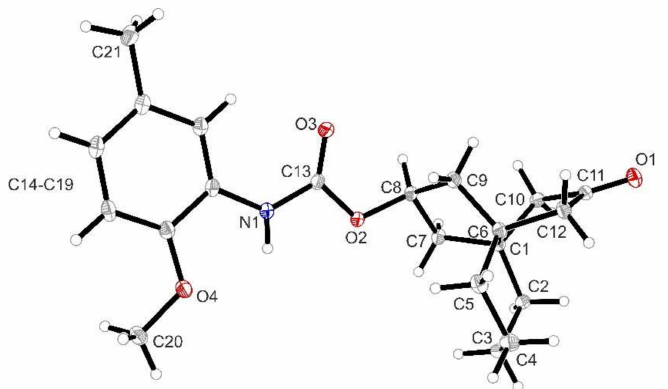
Figure 4. X-ray crystal structure of carbamate syn -7. Thermal ellipsoids are set at 15% prob- ability. Length of selected bonds: conjoining bond C1–C6 = 1.562(2) Å; C1–C2 = 1.529(2) Å; C1–C7 = 1.528(2) Å; C1–C10 = 1.538(2) Å. CCDC number: